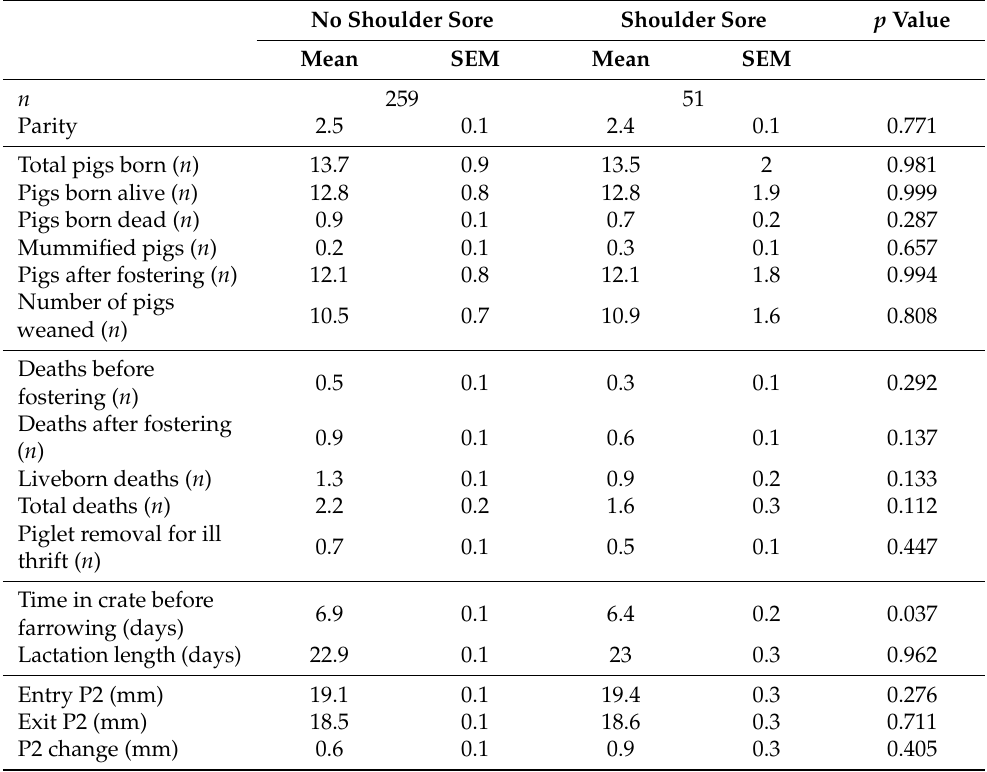
Table 3. Mean ± SEM of production data, piglet mortality, time spent in the farrowing accommoda- tion and P2 backfat changes. Significance considered p ≤ 0.05.